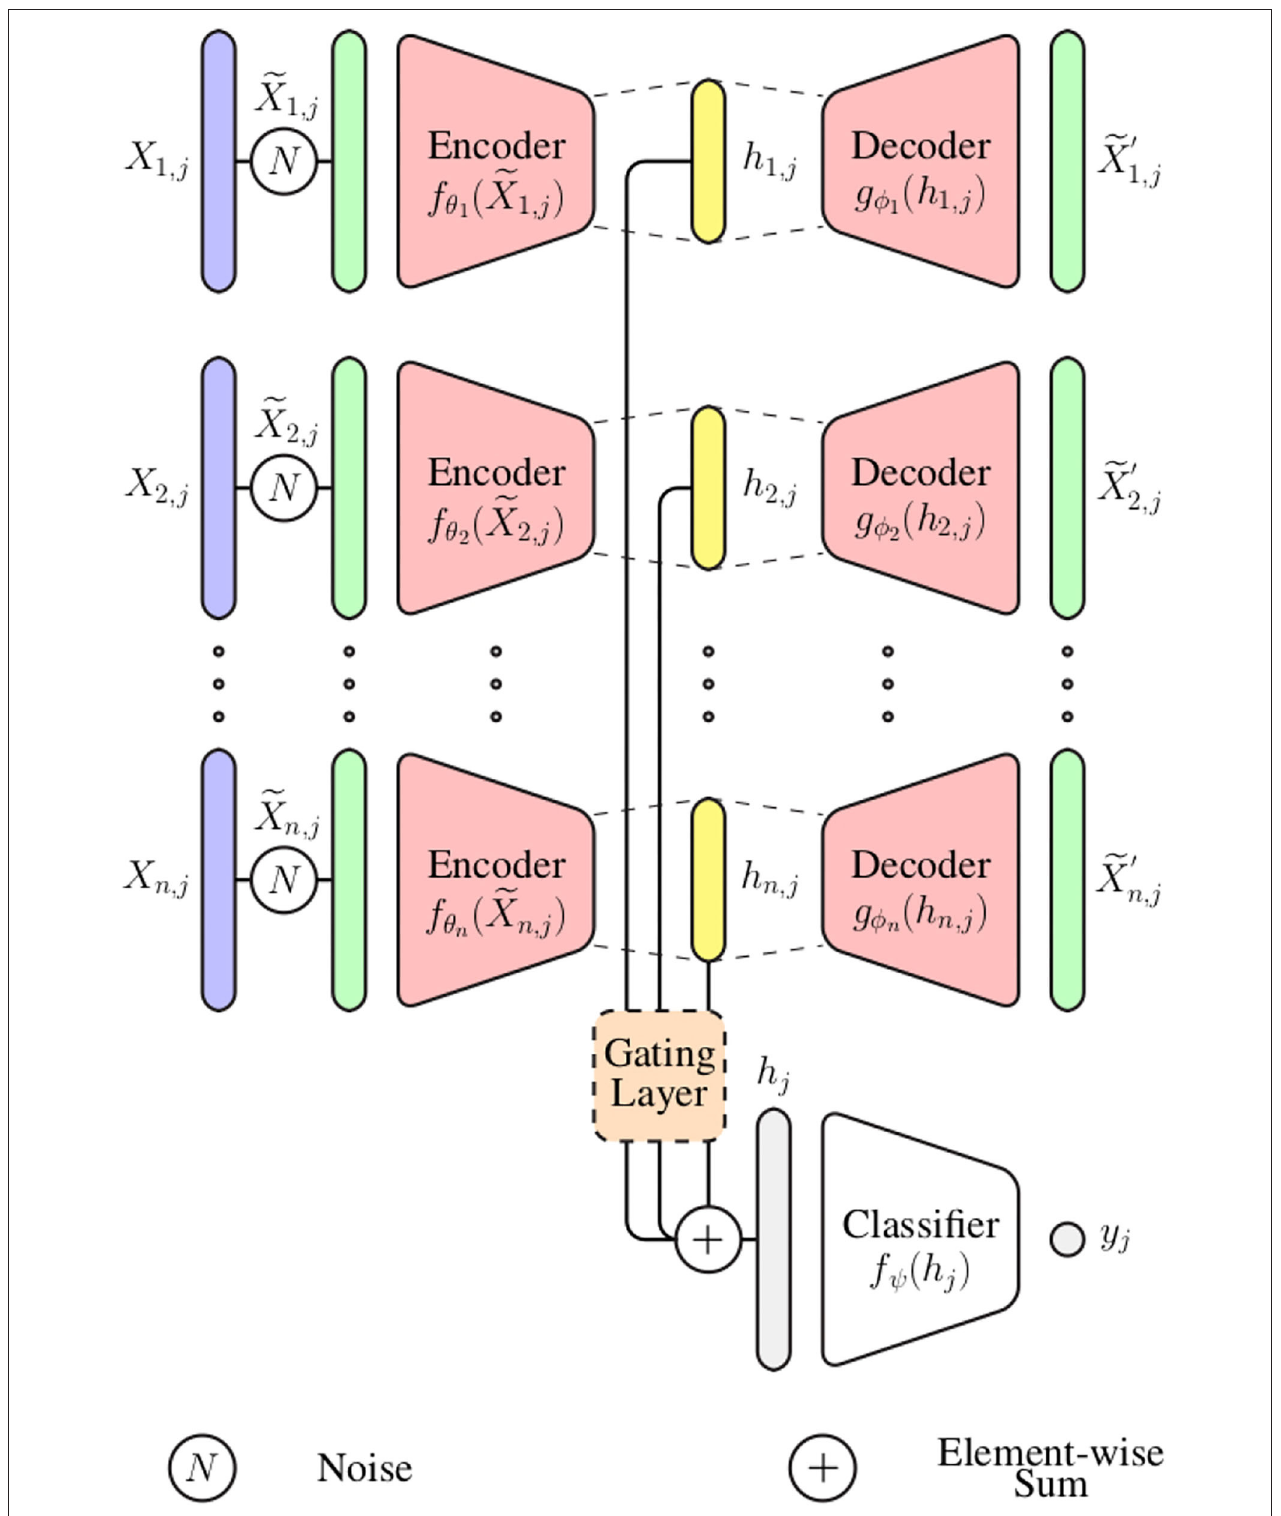
FIGURE 1 | Multi-modal deep denoising convolutional auto-encoder (DDCAE) architecture.